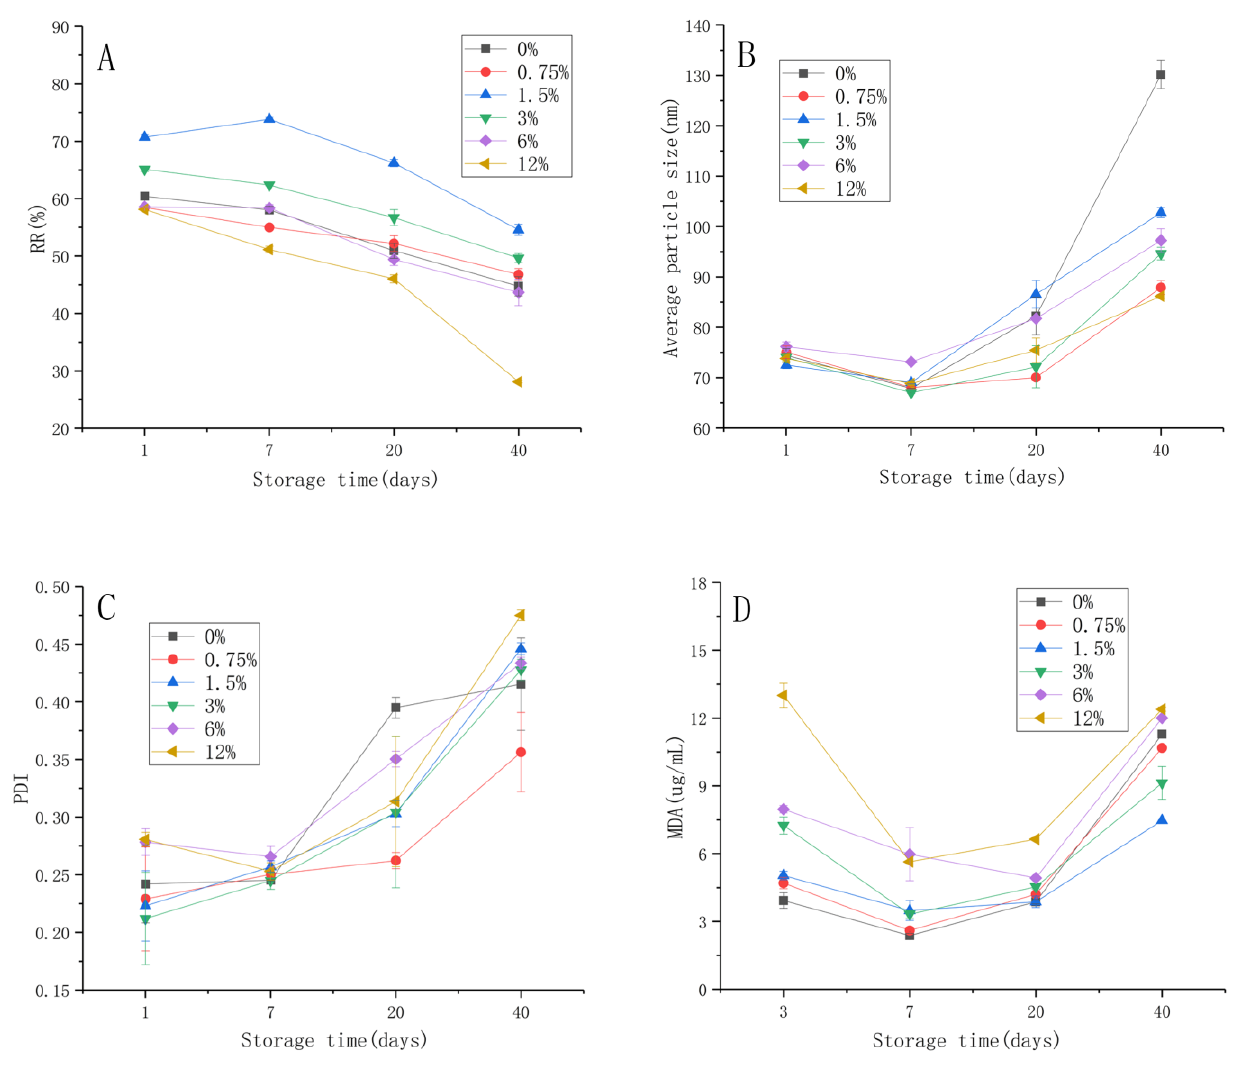
Figure 4. ( A ) Changes in the RR; ( B ) Particle size; ( C ) PDI; ( D ) The content of MDA (MDA value) of modified cinnamaldehyde liposomes with different inulin concentrations of storage. Results are represented as the mean ± sd (n = 3). RR: retention rate; PDI: polydispersion index; MDA: malondialdehyde.